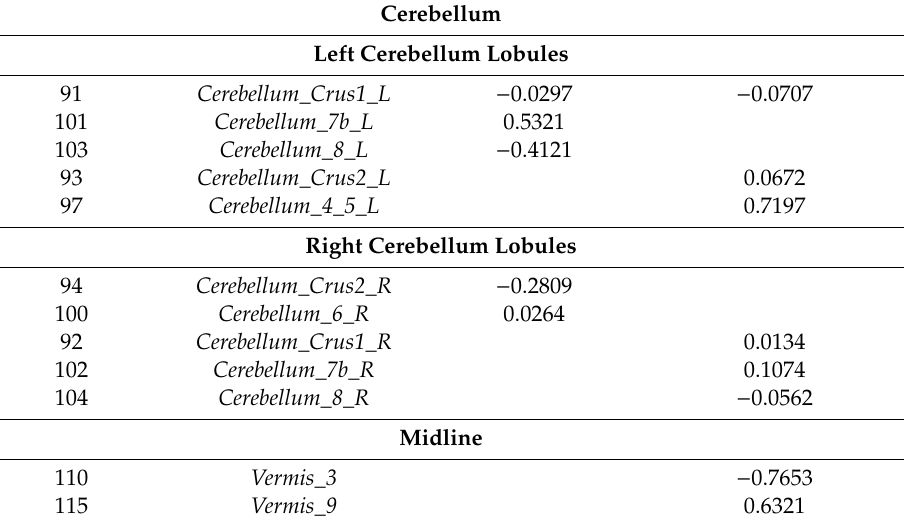
Table 4. Combinations of cerebral AAL regions predicting GWI versus control status. Logistic regression model coe ffi cients and voxels per AAL region were shown for models that predicted GWI versus control status prior to (Day 1) and after (Day 2) exercise. p < 0.05 for all reported variables once corrected using Sidak correction.